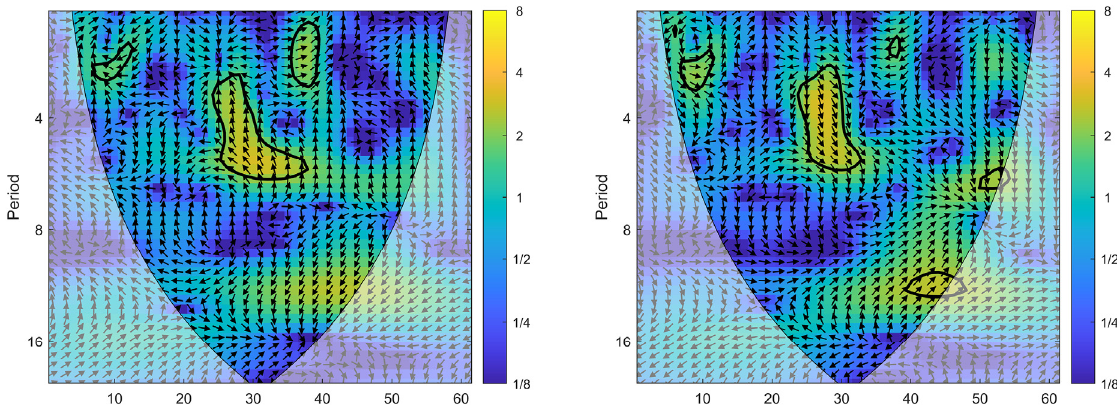
Figure 7. Regression coefficients ( a , b ) and regression VIP values of the PLS model ( c ) of extreme wet and dry events in Xinjiang (* is VIP value > 0.8, indicating a significant correlation).